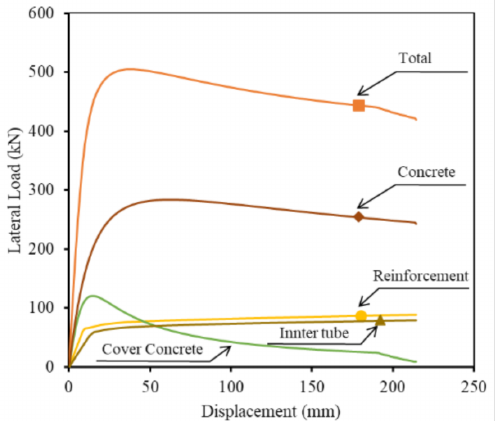
Figure 20. Lateral load-displacement of each member (S-S